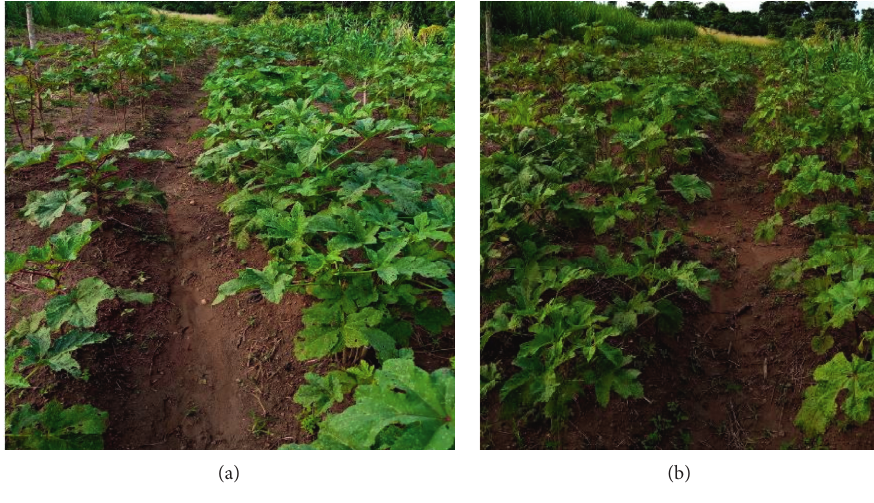
Figure 2: Vegetative stage of okra on the field.